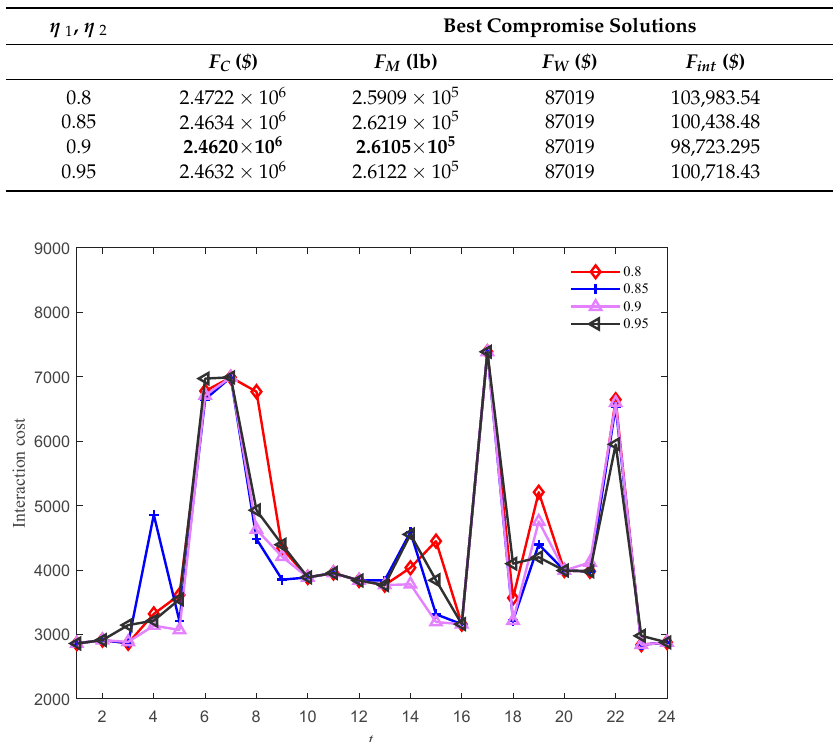
Table 11. The best compromise solutions obtained at different confidence levels.